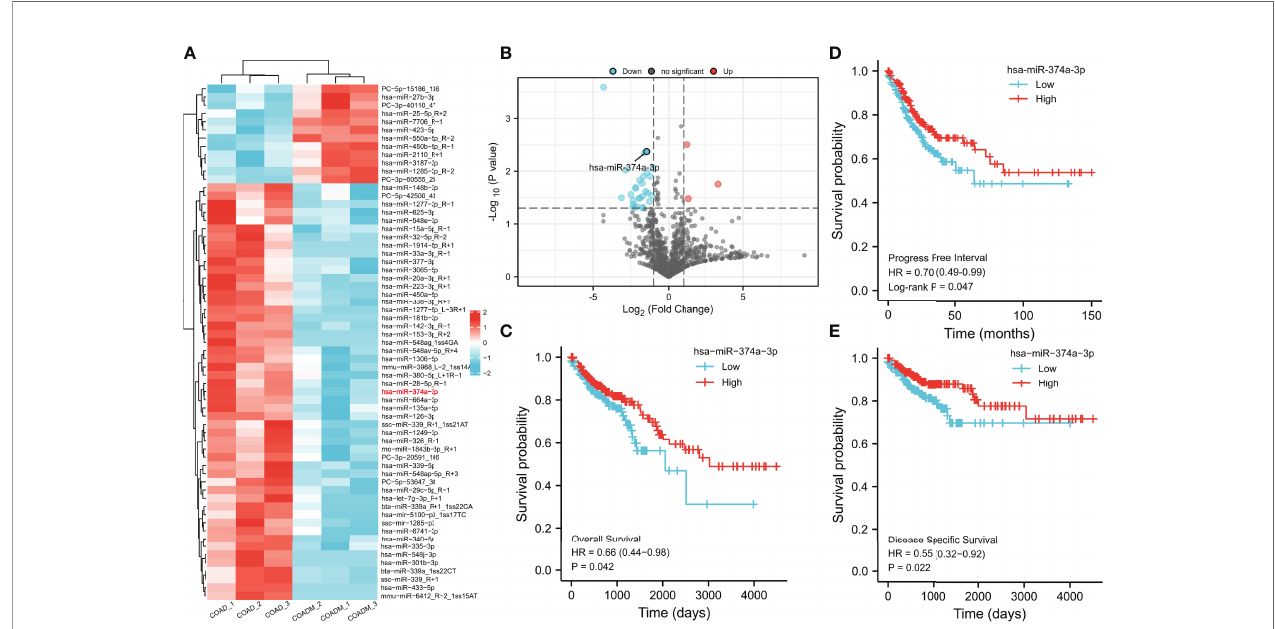
FIGURE 1 | Decreased expression of hsa-miR-374a-3p is bound up with poor prognosis of COAD patients. (A, B) Plasma from 6 COAD patients was collected for analysis of microRNA expression pro fi les by high-throughput RNA-seq. (C – E) Data from TCGA was used to verify the association between expression of has-miR- 374a-3p and prognosis (PFS, OS, and DSS) of